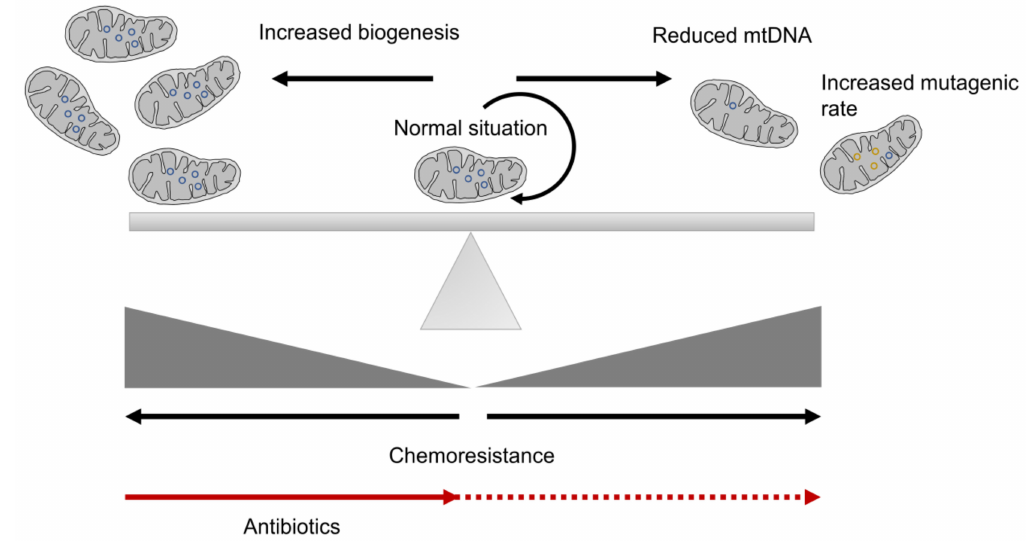
Figure 1. Mitochondrial biogenesis misbalance in cancer stem cells (CSCs). In normal cells, mitochondrial mass is usually maintained. However, both increased mitochondrial biogenesis, on the one hand, and alterations on mtDNA, on the other hand, are connected with an increased resistance in CSCs. Black arrows refer to increased chemoresistance, from a normal situation where mitochondrial biogenesis allows the maintenance of mitochondrial population. Treatment with antibiotics of CSCs with high mitochondrial biogenesis can overcome chemoresistance (red arrow), but prolonged treatments can force the appearance of a CSC population with reduced mtDNA (dotted red